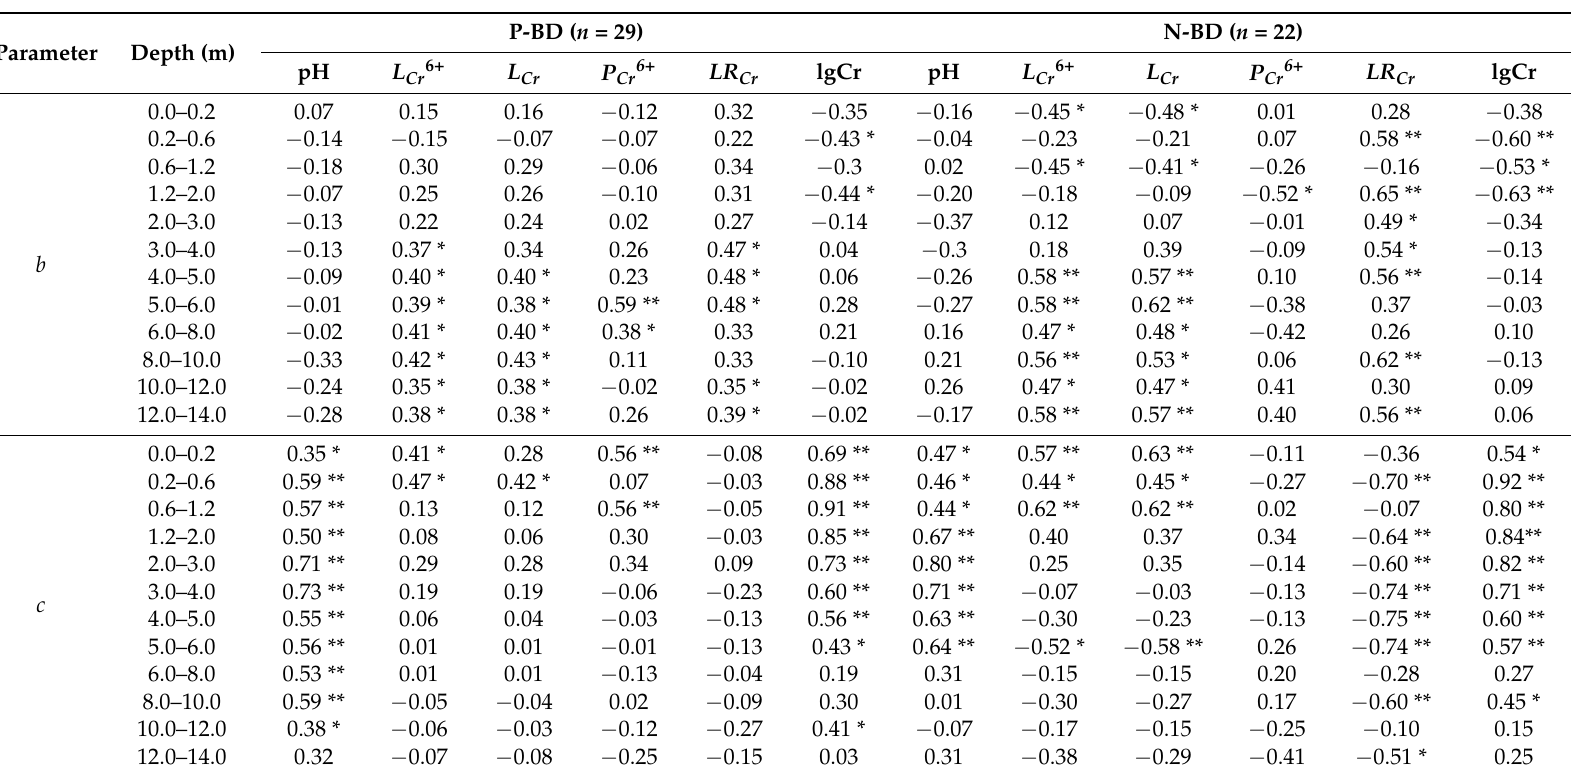
Table 5. The correlation coefficient of parameters to the factors of pH, lgCr, L Cr , L Cr 6+ , P Cr 6+ , and LR Cr in the different depths of